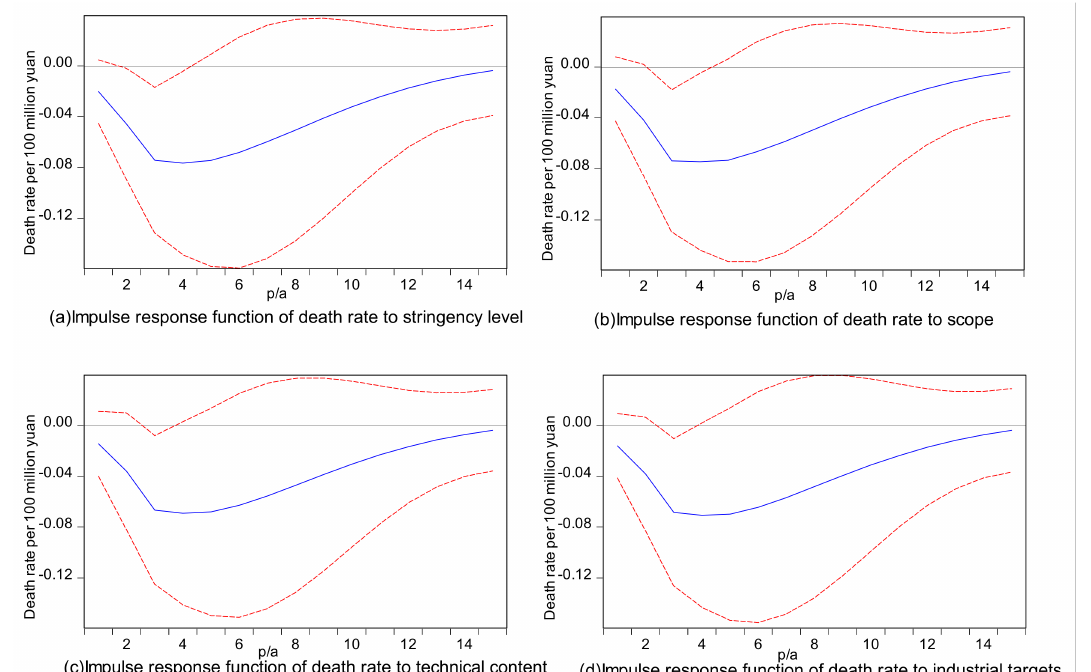
Figure 5. Impulse response function of the death rate to the safety policy indexes